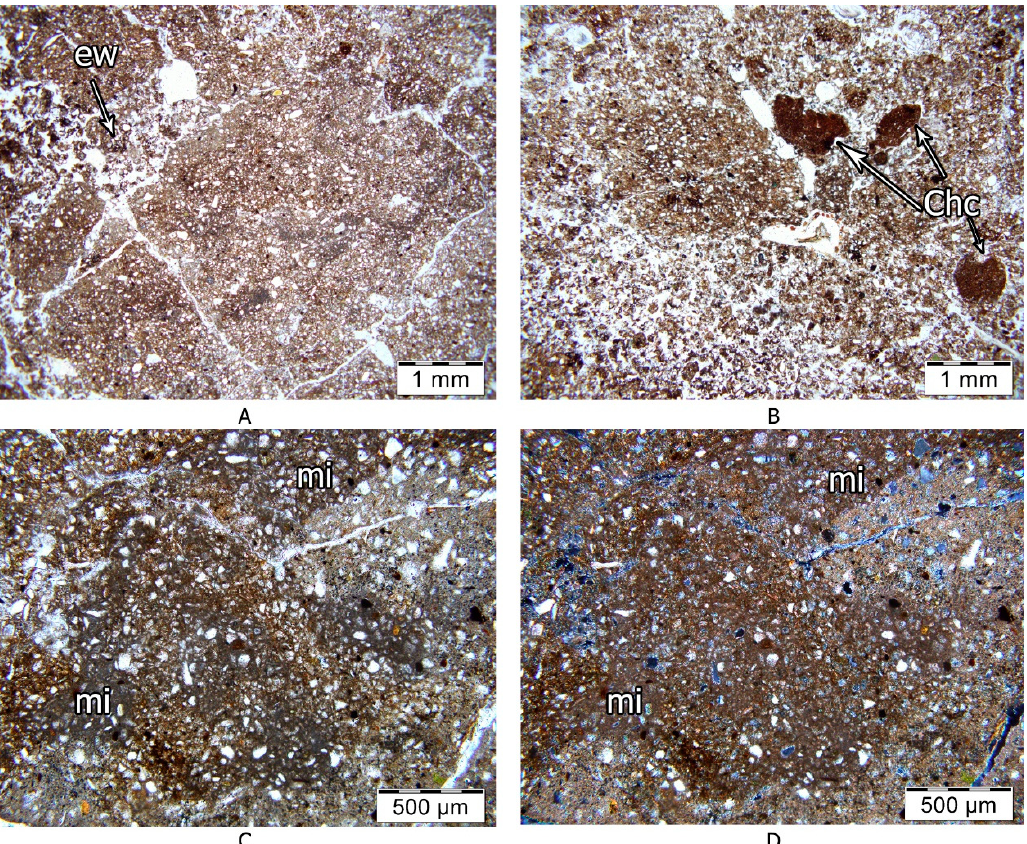
Figure 8. Microstructure of Calcic horizons. ( A )–rectangular structure of silty-clay carbonate material with earth-worm (ew) casts (65–80 cm, PPL); ( B )–silty-clay micromass with abundant fine fragments of Chocolate clays of various shapes (40–65 cm, PPL); ( C , D )–heterogeneous micritic impregnation (mi) of the groundmass (65–80 cm, ( C )–PPL, ( D )–XPL).